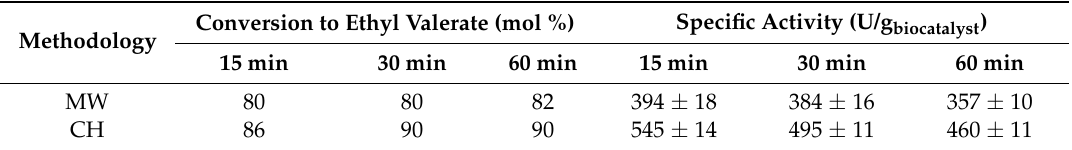
Table 8. Effect of reaction time on MW and CH conducted esterification of valeric acid under the main optimised reaction conditions. Conversion to Ethyl Valerate (mol %) Methodology